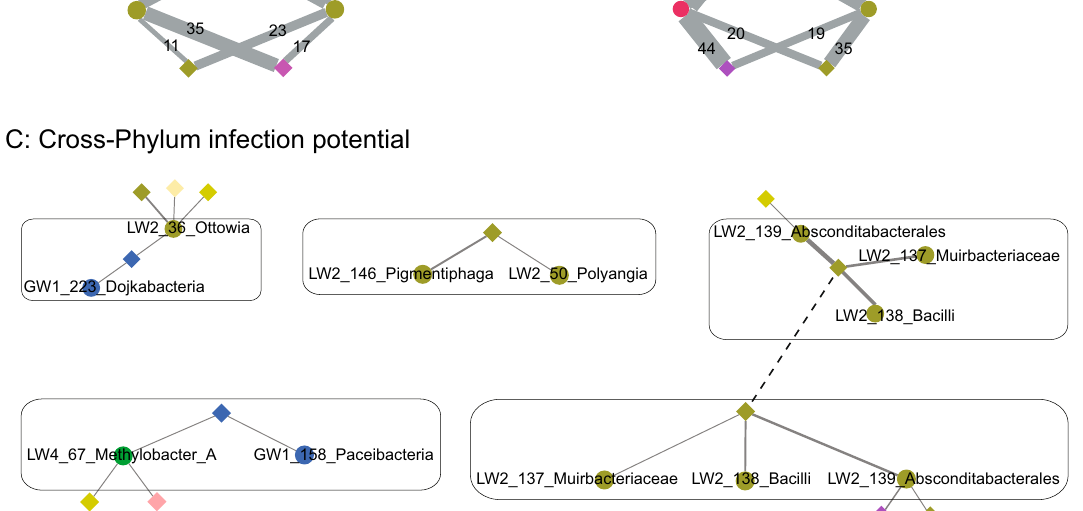
For the hosts, of the 36 2016-networked MAGs that passed dRep’s quality filtering, 16 (~ 44%) were represented in the 2017 MAG dataset as a whole, and only three (~ 8%) were present in the 2017 network (Supplemental Fig. S7). Two virus-host pairs were shared between the 2016 and 2017 networks (i.e., viral elements clustered at 95% global sequence ID, hosts collapsed by dRep). Each of the two host MAGs in 2017 shared no spacers in their encoded CRISPR arrays with their 2016 counterparts, meaning each host targeted the same viral element with different CRISPR spacers in each year. In one of the host MAGs, the CRISPR arrays shared an exact match in a